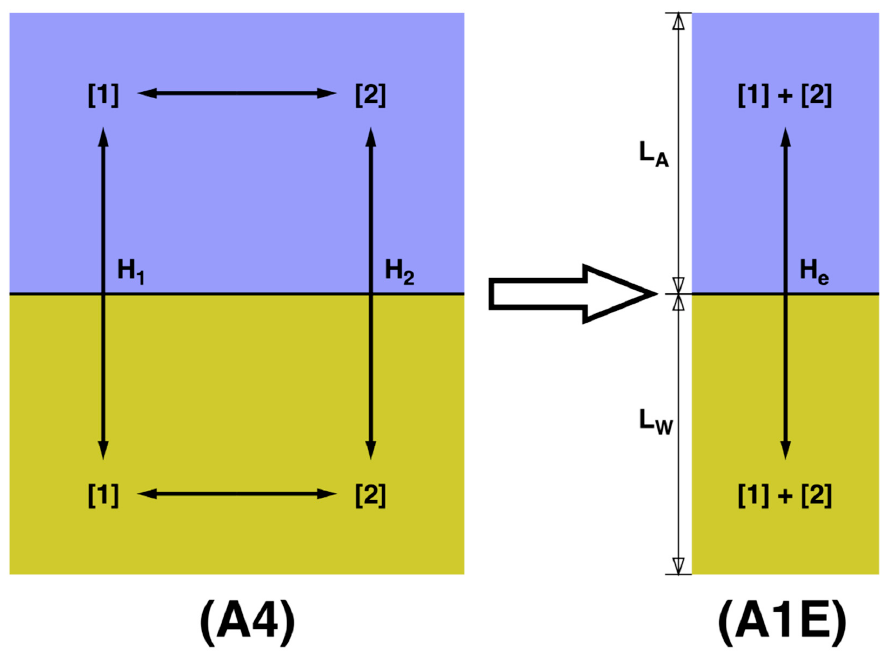
Figure 2. A fifth model, A1E, can be considered if we treat 1 + 2 as a blended compound.